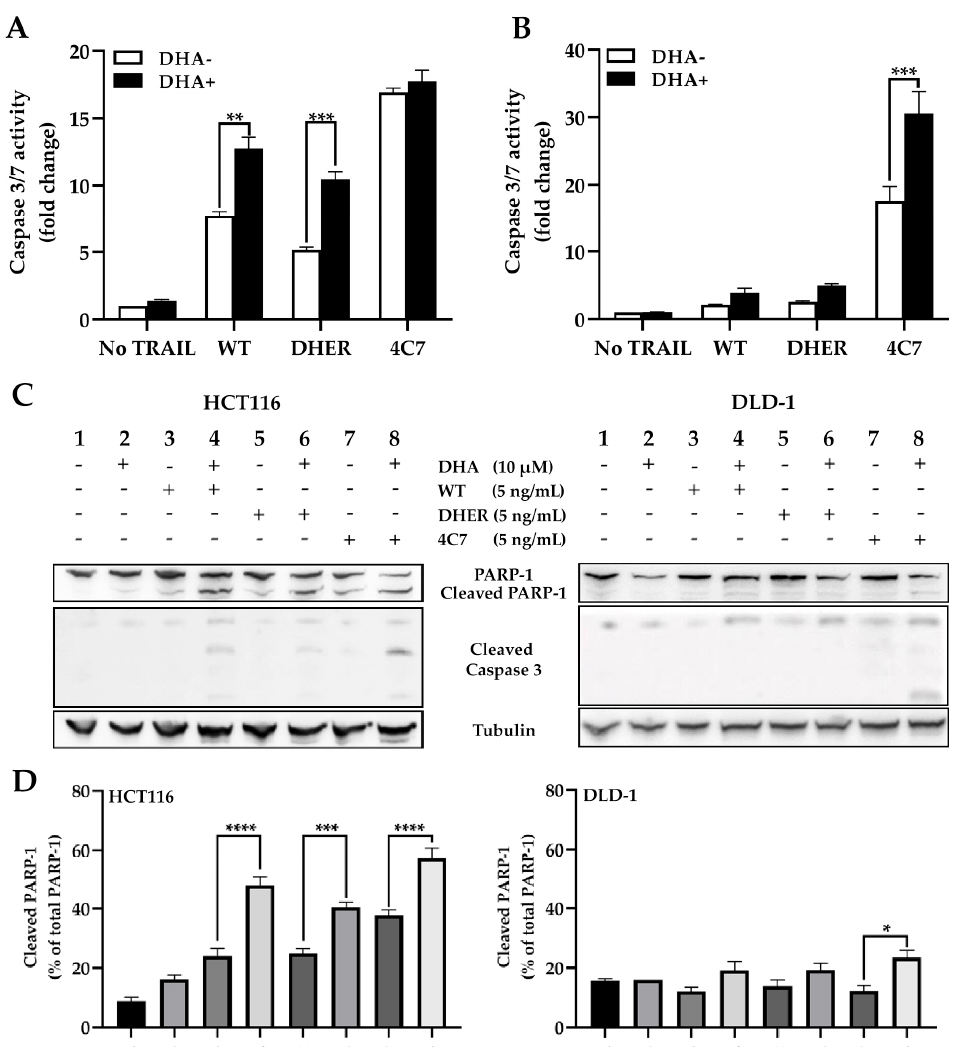
Figure 4. DHA activates caspase-mediated cell death differently through the two receptors. The caspase-3 / 7 activity was performed on HCT116 ( A ) and DLD-1 ( B ), and the luminescence was measured after 1 h reagent incubation. Data shown are mean ± SEM from two independent experiments performed in triplicate. ( C ) Western blot analysis of full-length PARP-1, cleaved PARP-1, and cleaved caspase-3 using γ -Tubulin as the loading control. ( D ) The cleaved PARP-1 relative to total PARP-1 was calculated based on integrated density relative to γ -Tubulin. Figure S1A,B show the original Western blot. All cells were treated with 10 µ M DHA for 30 min, followed with / without 5 ng / mL rhTRAIL WT, DHER, or 4C7 for 12 h to check the caspase-3 / 7 activity, 24 h for Western blot. p values were analyzed by two-way ANOVA with Sidak’s multiple comparisons test in Graphpad Prism version 8.0. * 0.01< p ≤ 0.05, ** 0.001< p ≤ 0.01, *** 0.0001< p ≤ 0.001, **** p ≤ 0.0001.